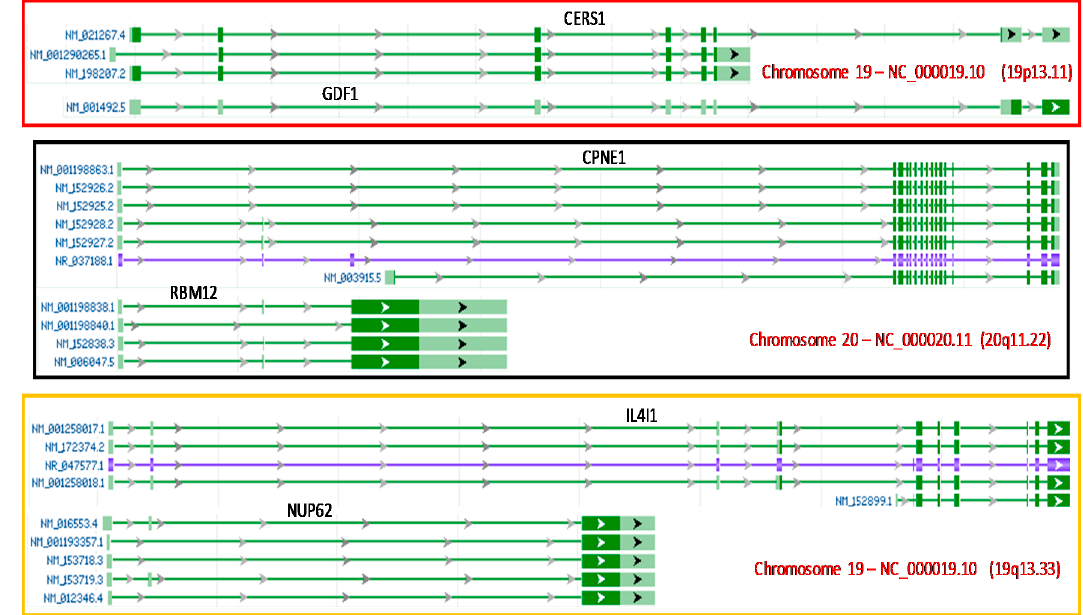
Figure 4. Images copied and modified from the NCBI database illustrating that one human genomic locus harbors two genes whose RNAs not only are transcribed from the same initiation site but also share exons. Top panel : The CERS1 and GDF1 genes are encoded by the same human genomic locus at the 19p13.11 region, and the GDF1 mRNA is identical to the largest CERS1 mRNA, but the same mRNA codes for different open reading frames (ORFs) for the GDF1 and the CERS1 genes. Middle panel : The CPNE1 and RBM12 genes are encoded by the same genomic locus at the human 20q11.22 region and are transcribed from the same initiation site. While the CPNE1 transcripts may be cis -spliced to six mRNAs and one noncoding RNA, the RBM12 transcripts may be cis -spliced to four mRNAs. The CPNE1 RNAs share some exons with the RBM12 RNAs. Bottom panel : The three mRNAs and one noncoding RNA of the IL4I1 gene share some exons with the five mRNAs of the NUP62 gene, and both genes locate at the same genomic locus in the human 19q13.33 region, with some RNAs of these two genes sharing the same transcription initiation site.